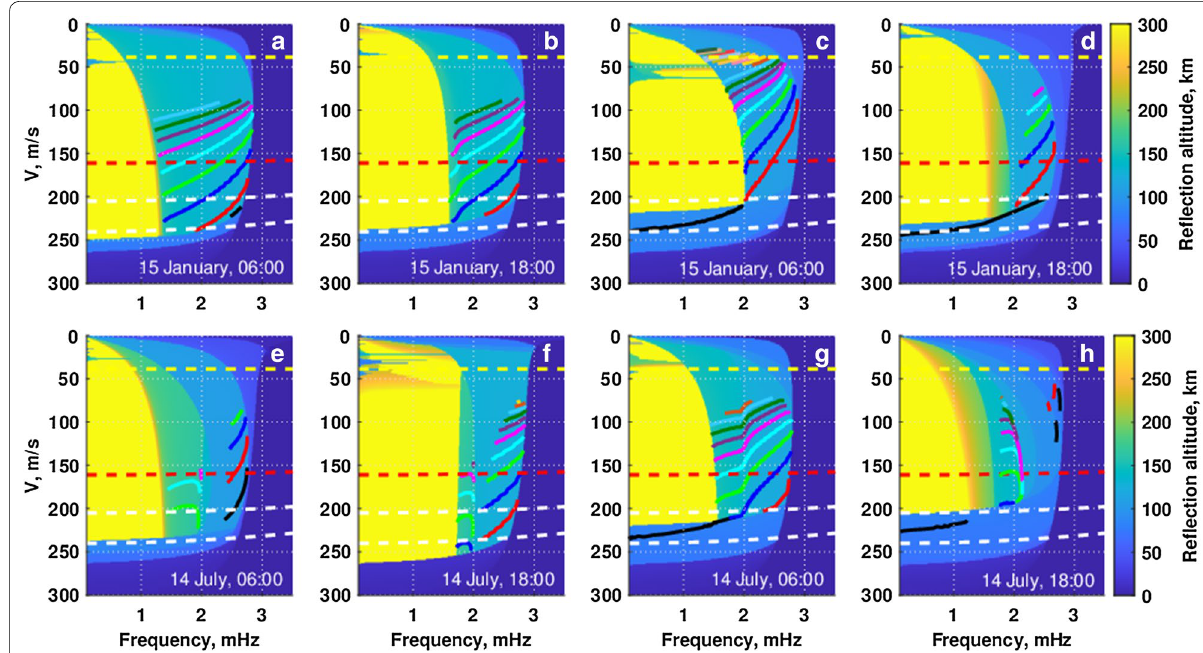
Fig. 5 Predicted buoyancy resonances of a mid-latitude atmosphere and their variability. Frequencies of buoyancy resonances of orders n from 1 to 15 are shown by solid lines, with black lines corresponding to n 1, in a wide range of trace velocities. Color scale represents the altitude of = AGW turning point. The overlaid dashed lines show dispersion curves of infragravity waves in the ocean with depth of 150 m (yellow), 2649 m (red), 4300 m (top white) and 5900 m (bottom white). The background atmospheric temperature and wind velocity profiles used in the simulations are obtained for Wallops Island, Virginia, with the NRLMSISE-00.2 (Picone et al. 2002) and HWM14 (Drob et al. 2015) models for two specific dates corresponding to winter and summer seasons: 15 January 2014 ( a – d ) and 14 July 2014 ( e – h ). For each date two times of the day, GMT 06:00 ( a , c , e , g ) and GMT 18:00 ( b , d , f , h ), and two directions of the wave propagation, eastward ( a , b , e , f ) and westward ( c , d , g , h ) are shown